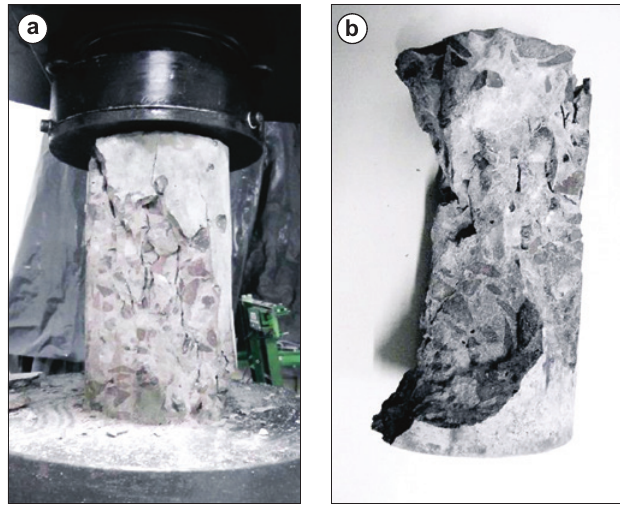
Figure 4 Stress vs. strain plots for the reference concrete samples and sample S3, cast in horizontally placed cylinder